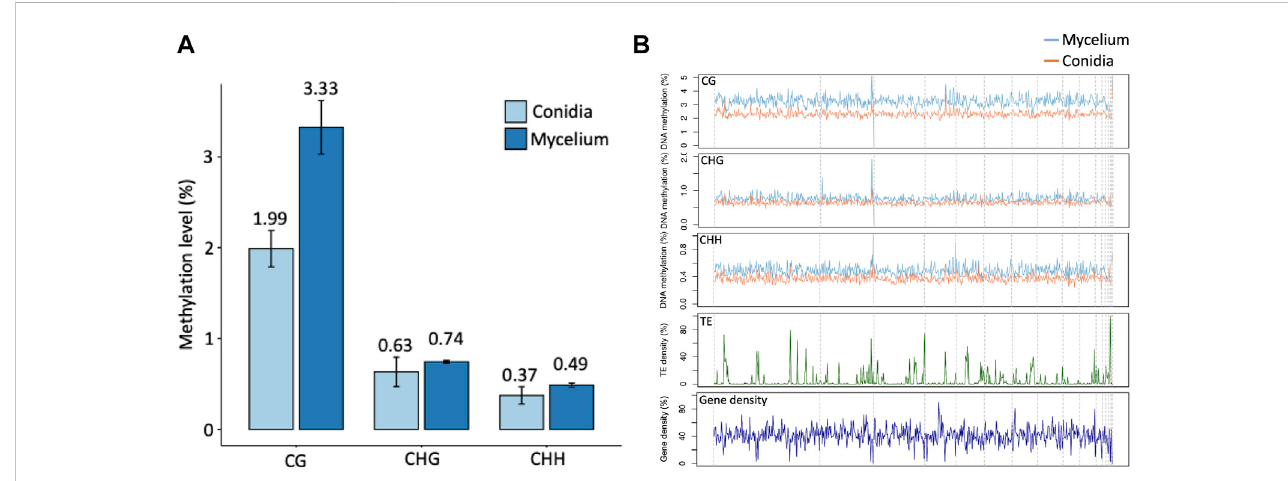
FIGURE 3 GlobalpatternsofDNAmethylationinBb-NCHU-157. (A) Averagemethylationlevelsinconidiaandmycelium. (B) CG,CHG,andCHHmethylationlevels in Bb-NCHU-157 genome and the densities of Transposable elements (TE) and genes for the same contigs.